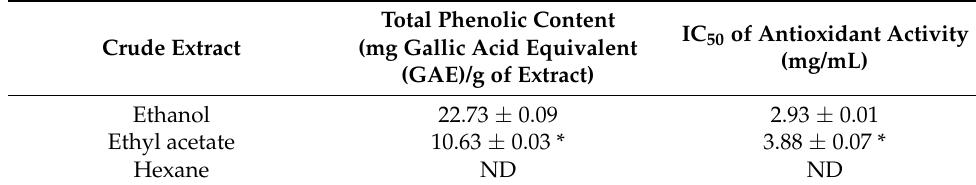
Table 1. The total phenolic content and antioxidant activity of the crude extracts of banana inflores- cence.